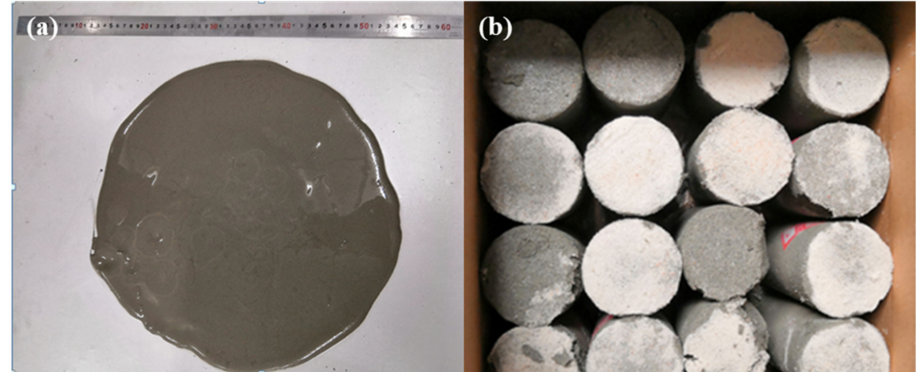
Figure 3. ( a ) Fresh and ( b ) hardened